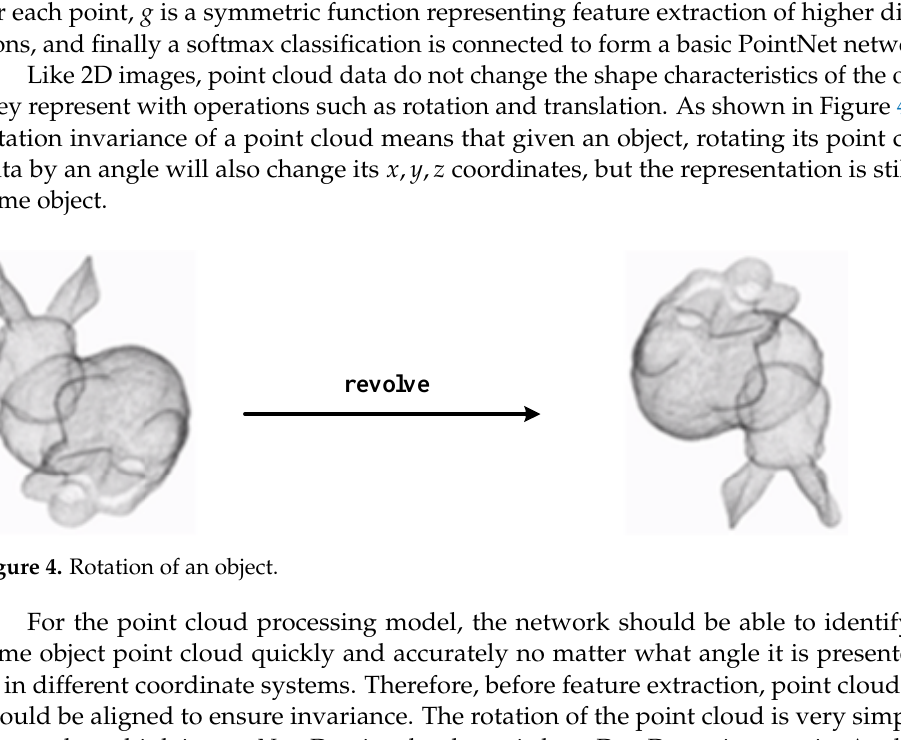
Figure 3. Simple feature extraction network. ( a ) Feature extraction using Max function; ( b ) PointNet network basic structure.